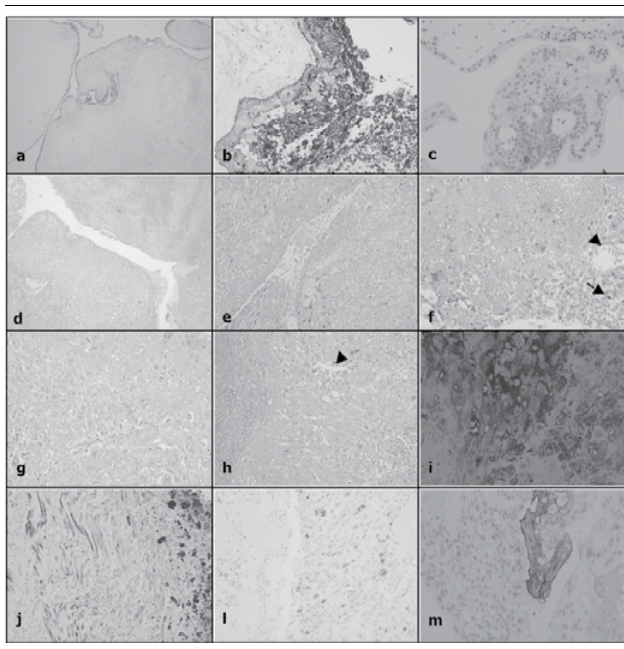
figurE 3 – Histological examination (Hospital Prof. Dr. Fernando Fonseca, Amadora, Portugal and Centro de Genética Clínica, Porto, Portugal) Post-molar trophoblastic neoplasia: A) HE, villi with marked edema with formation of cistern with acellular center, without blood vessels, absence of normal villi; B) marked proliferation of trophoblast, positivity for β -hCG (+++); C) PLAP (+). Endomyometrial invasive lesion: D-H) HE, CC component with pleomorphism and acellular atypia, mitoses (arrow), polarization to vascular structures (arrow head), hemorrhage and necrosis. Immunohistochemical profile: I) strongly marked β -hCG (+++); J) strongly expressed AE1/ AE3 (+++), straight muscle fibers with weak expression for epithelial markers and in the PSTT component; L) weakly marked inhibin (+); M) moderately marked PLAP (++). HE: hematoxylin and eosin; β -hCG: beta subunit of human chorionic gonadotropin; PLAP: placental alkaline phosphatase; CC: choriocarcinoma; PSTT: placental-site trophoblastic tumor.